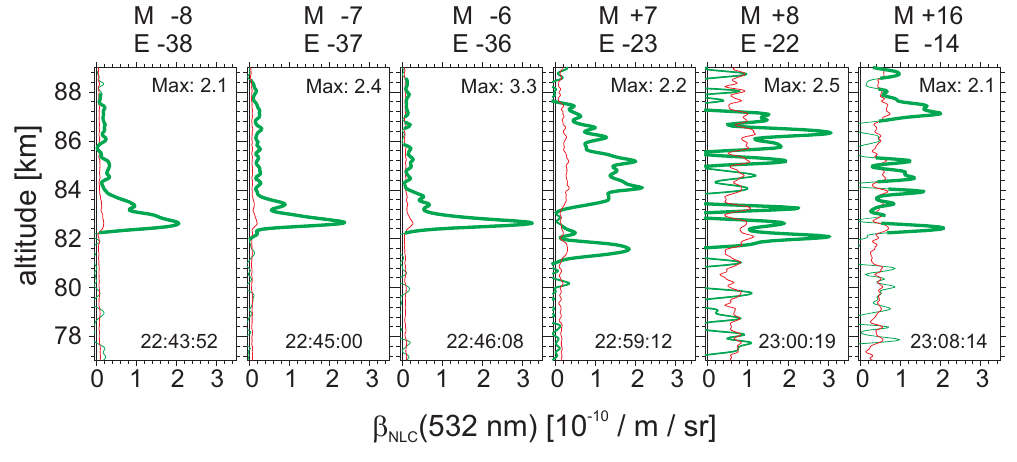
Fig. 3. Sequence of altitude profiles of backscatter coefficients derived from observations with the ALOMAR RMR lidar. The labels over each of the panels indicate the relative time in minutes to the MASS (M) and ECOMA (E) launches. Thin green lines show the actual measurements, whereas red lines indicate the noise level. Thick green lines indicate altitude-regions with continuous signals which exceed the noise level by at least one standard deviation and which are hence identified as NLC.